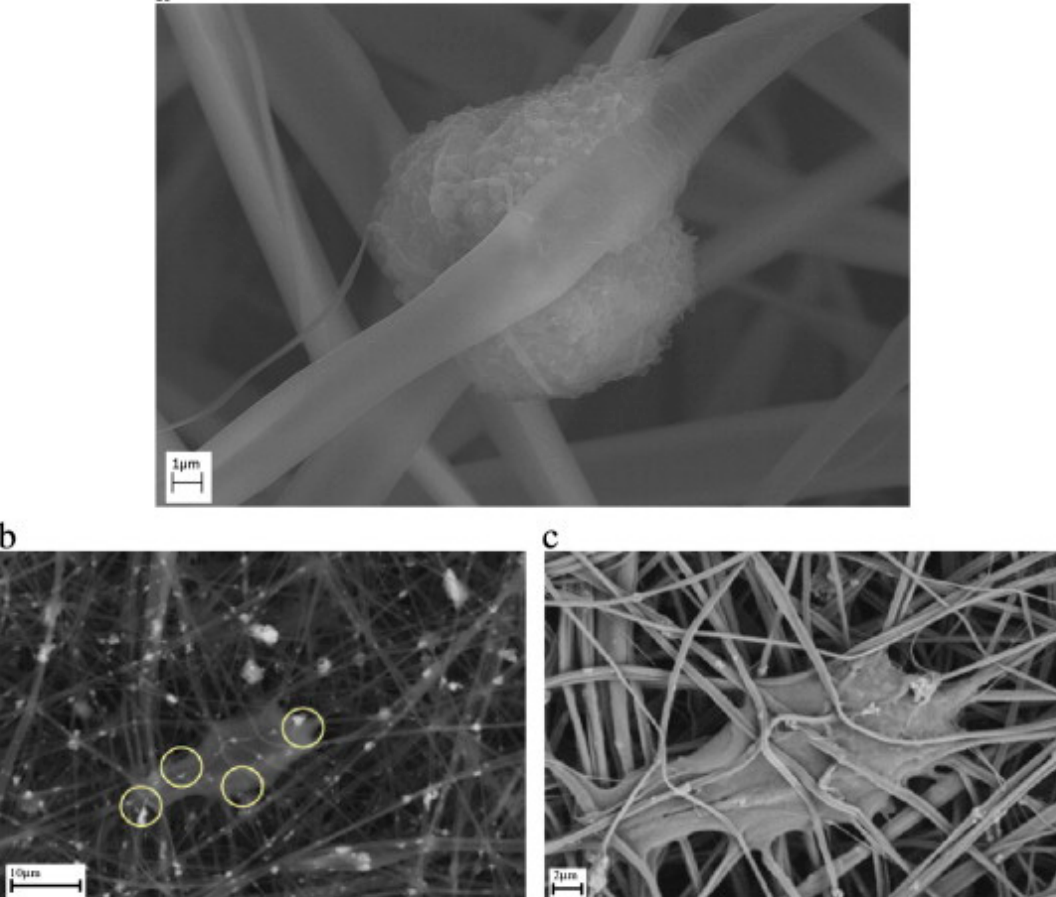
Figure 5 . Differences between osteoblast cells grown on neat cellulose acetate fibers ( a ) and composite cellulose acetate/nano-hydoxyapatite fibers at low ( b ) and high ( c ) magnification (reproduced with permission from Ref. [81]).